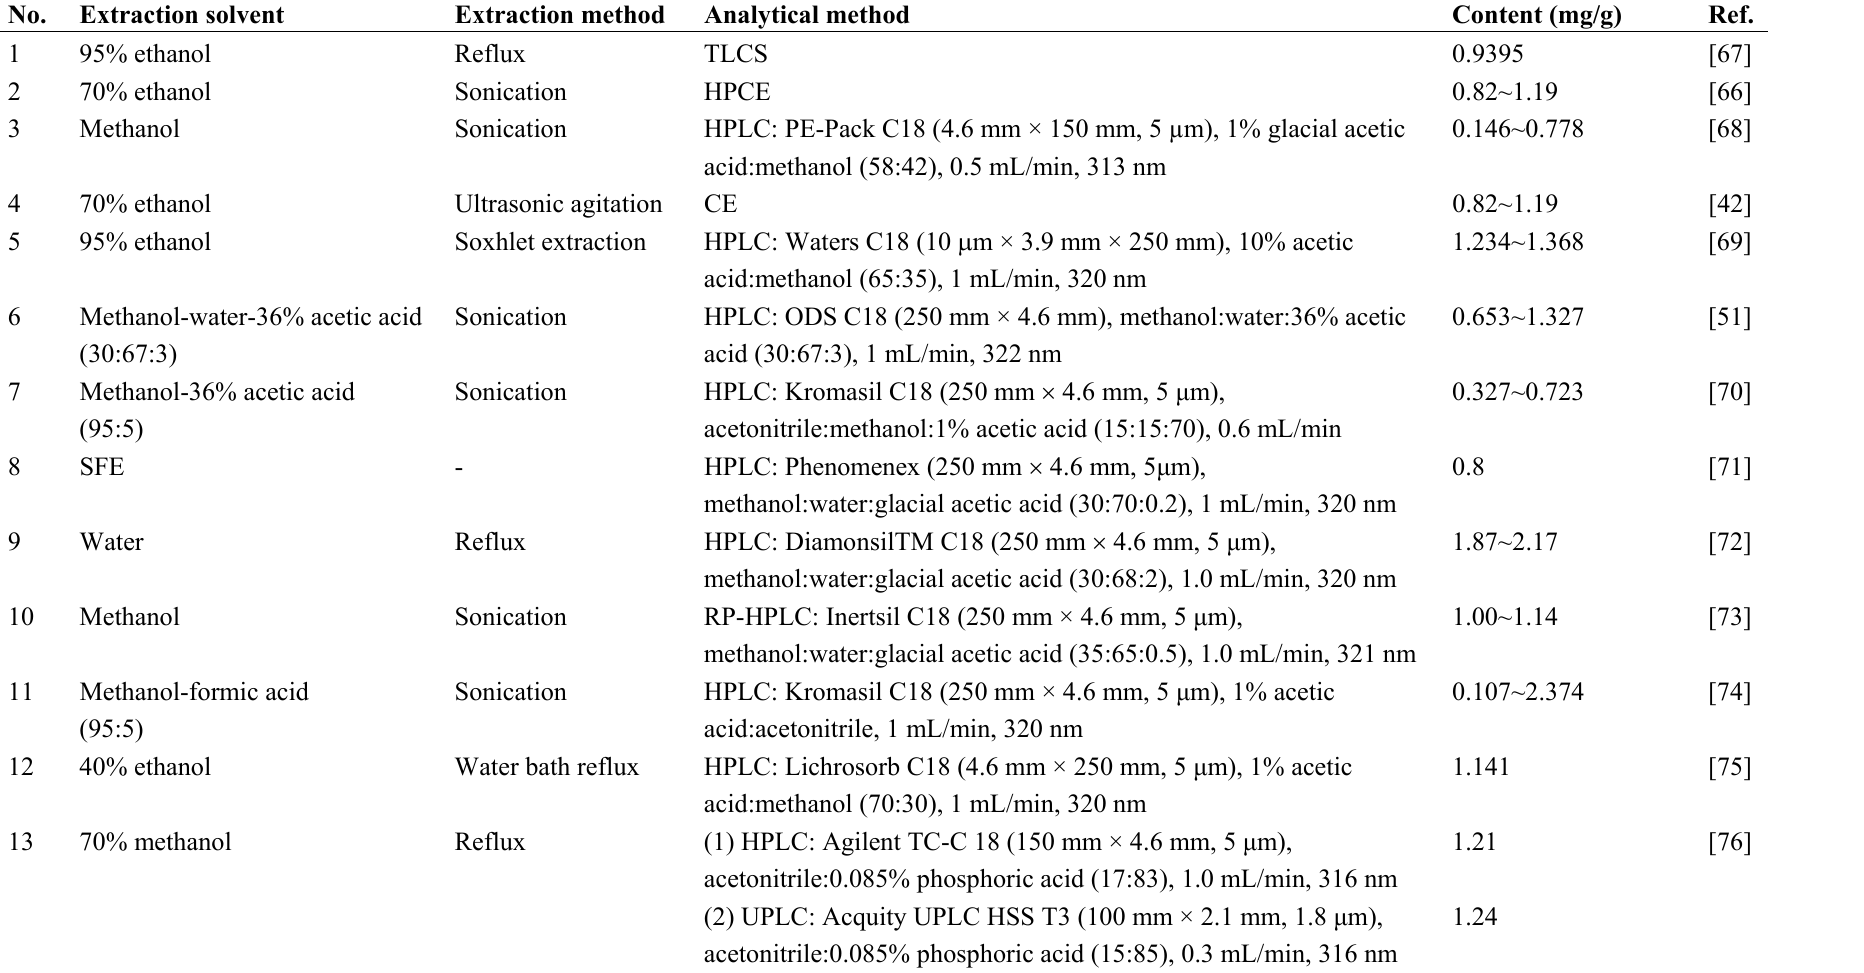
Table 2. The concentration variation of ferulic acid ( 1 ) in CX analyzed by different